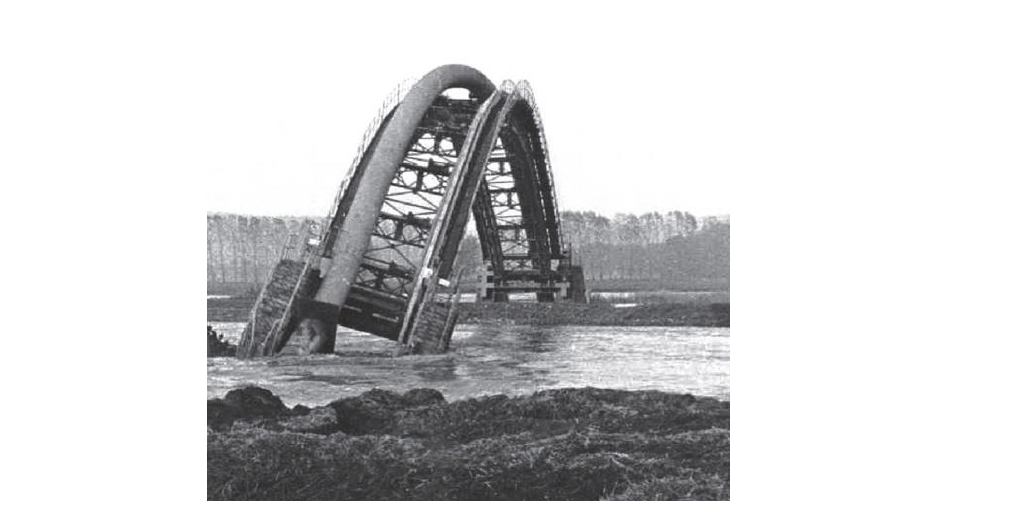
Figure 4. Destruction of the supporting structure of the bridge during the floods in 1974 on the Slaná River. Slan á